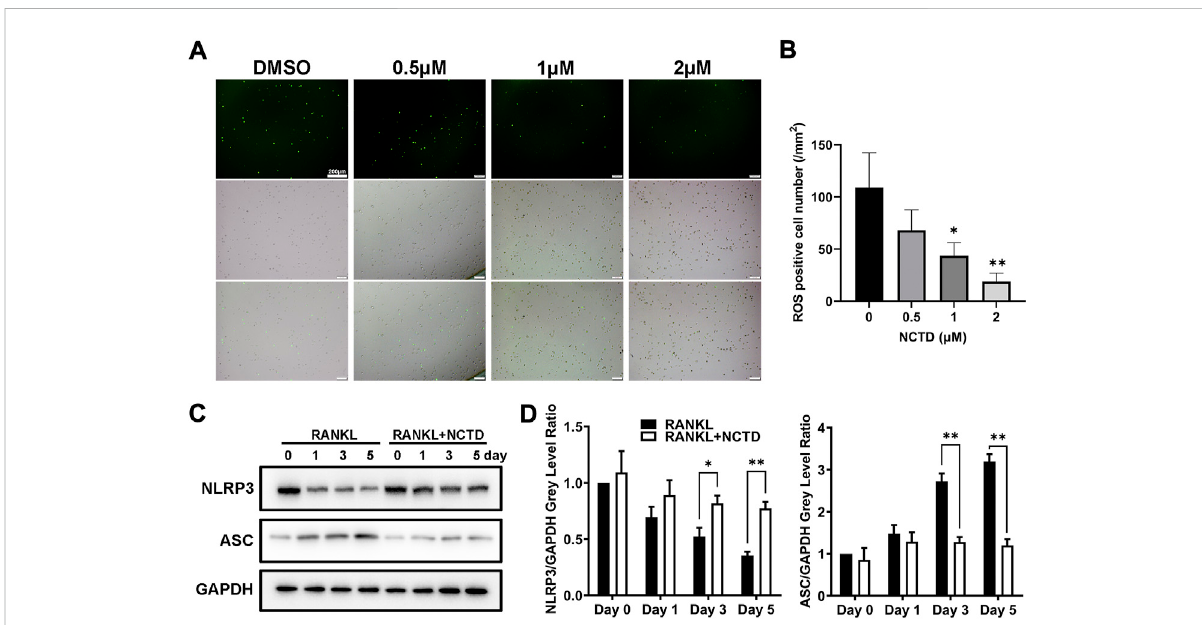
FIGURE 3 NCTD reduced the content of ROS and inhibited the formation of in fl ammasome in BMM cells. (A) During BMM differentiating into osteoclast withRANKL,ROSkitwasusedtodetecttheROScontentinBMM. (B) TheROSobservedunder fl uorescencemicroscopewasquanti fi ed. (C) Western blotting was used to measure NLRP3 and ASC expression level in BMM induced osteoclasts at day 0, 1, 3, and 5. (D) The NLRP3 and ASC bands of Western blotting were quanti fi ed. All experiments were repeated independently for three times. Values are expressed as mean ± SD; * p < 0.05, ** p < 0.01 vs. the control